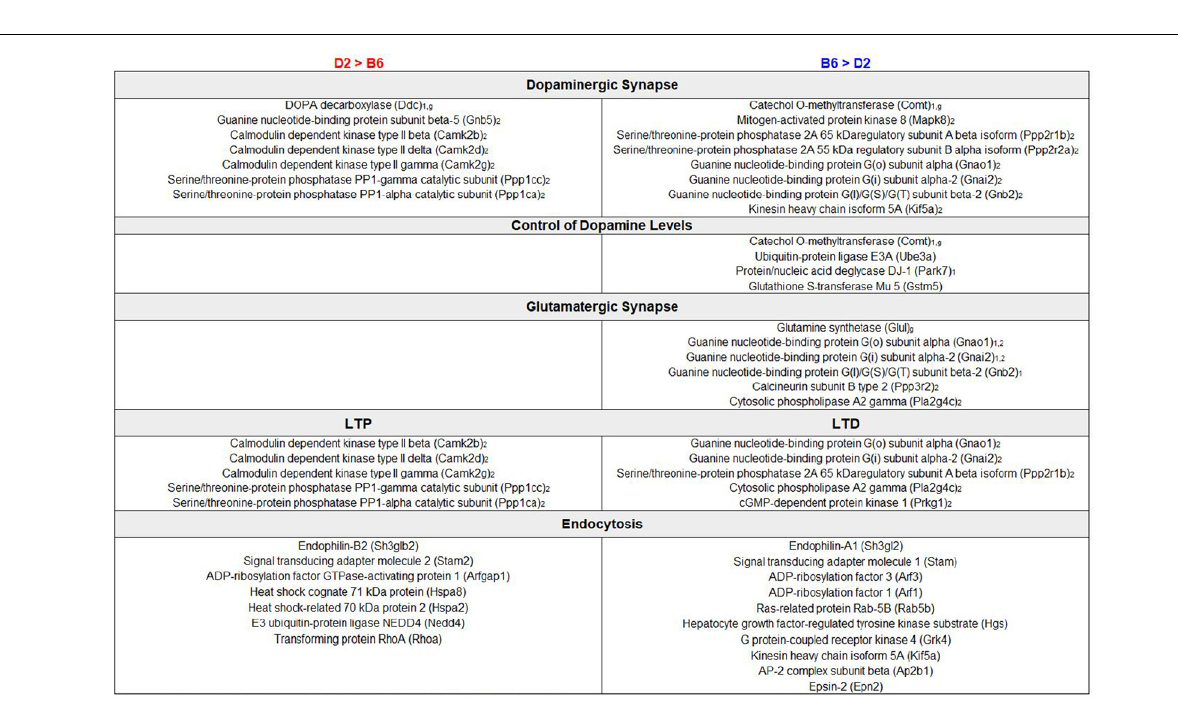
D2 male mice using an RNA-seq platform (Bottomly et al., 2011). The comparative analysis revealed that only 41 of the 160 DE proteins (26%) demonstrated significant strain differences at